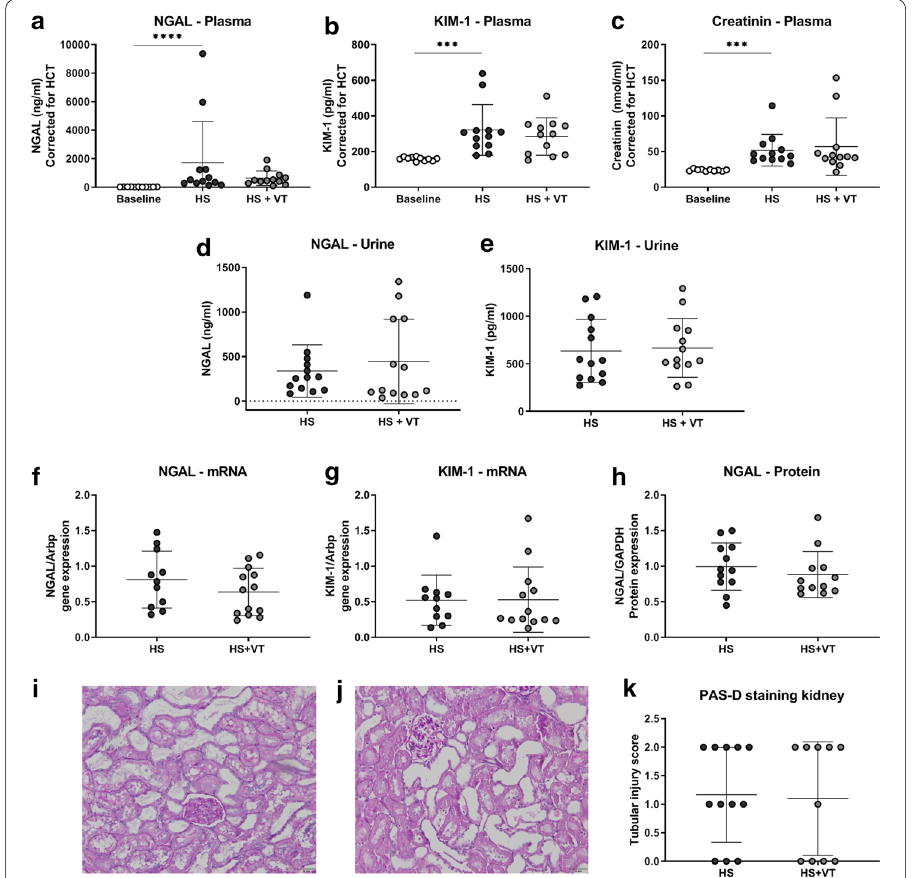
Fig. 4 Expression levels of renal injury markers. Plasma levels of NGAL ( a ), KIM-1 ( b ) and creatinine ( c ), measured at baseline (white circles) and following hemorrhagic shock and fluid resuscitation (HS; black circles, HS VT; grey circles). Urinary levels of NGAL ( d ) and KIM-1 ( e ), measured following hemorrhagic shock + and fluid resuscitation (HS; black circles, HS VT, grey circles). Renal gene expression of NGAL ( f ) and KIM-1 + ( g ), and renal protein expression of NGAL ( h ) measured following hemorrhagic shock and fluid resuscitation (HS; black circles, HS VT; grey circles). Microphotographs (original magnification 20) of PAS-d stained + × renal tissue sections from untreated HS rats ( i ) and VT-treated HS rats ( j ), showing similar degrees of ischemic tubular injury, as evidenced by tubular dilation and loss of brush borders, tubular injury scores represented in graph ( k ). Data represent mean SD. Plasma: Kruskal–Wallis with Dunn’s analyses. Gene and protein ± expression: Student’s T-test. *P < 0.05 HS group compared to baseline; # P < 0.05 HS VT vs. HS group. VT + vasculotide, NGAL neutrophil gelatinase-associated lipocalin, KIM-1 kidney injury